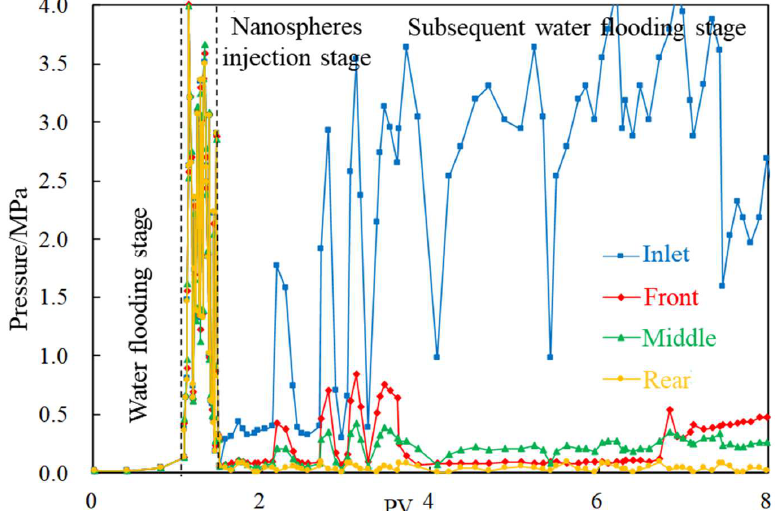
Figure 4. Pressure change curve (800 nm nanospheres).